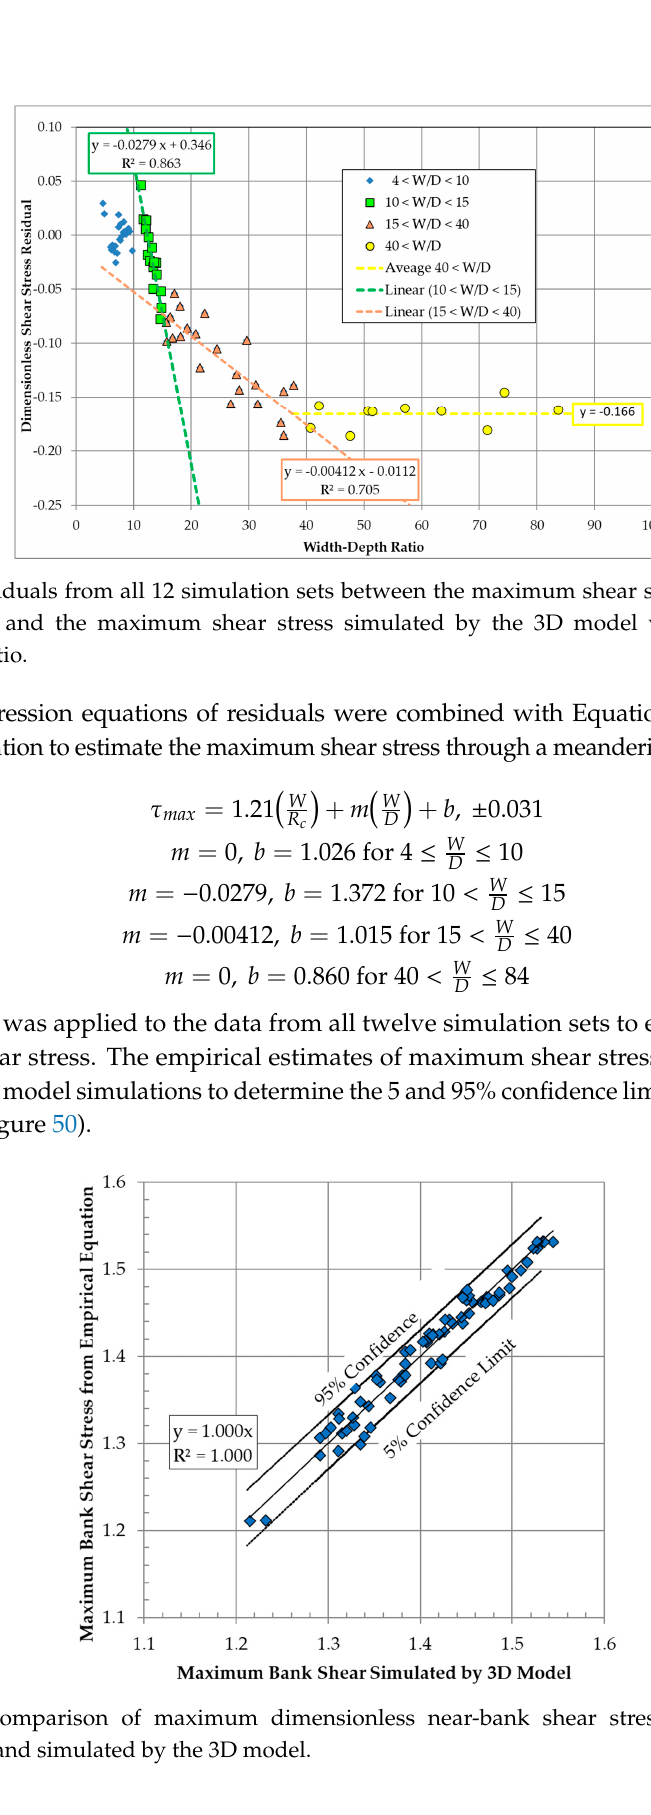
Figure 51. Correlation of dimensionless shear stress phase lag and channel sinuosity using data from all 12 simulation sets.